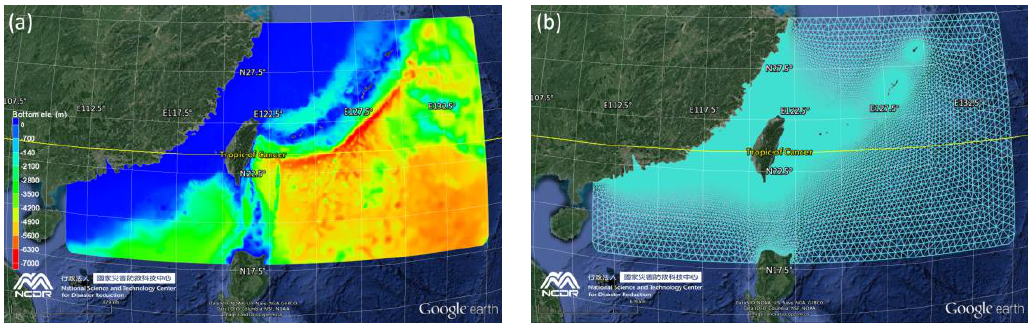
Figure 4. ( a ) Bathymetry and ( b ) unstructured grid of the computational domain.